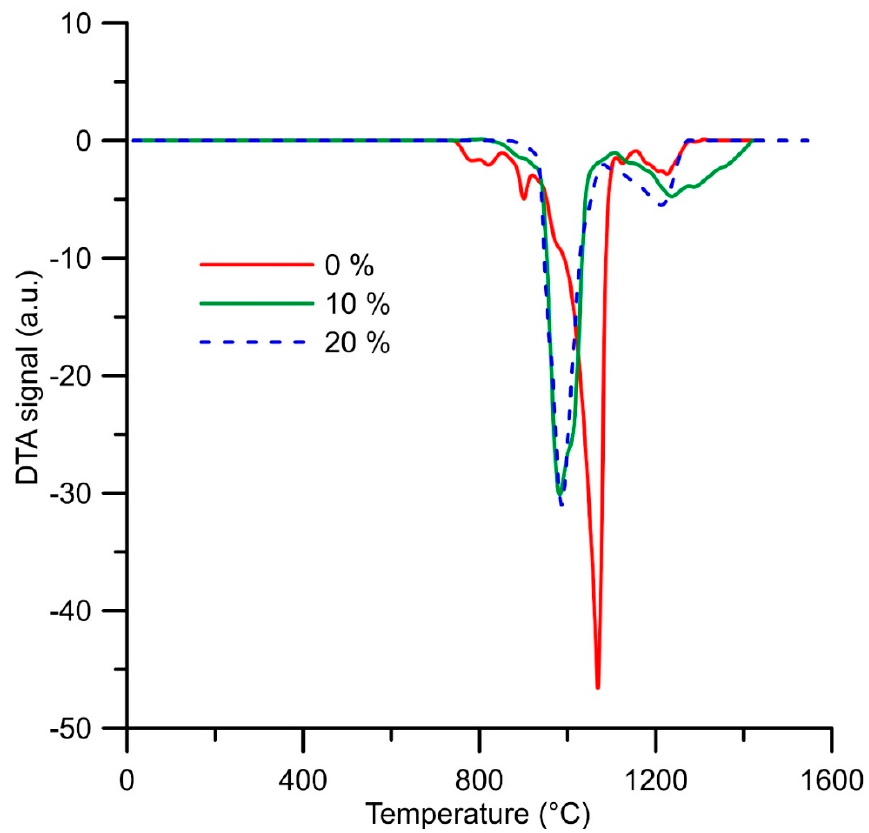
Figure 8. DTA heating curves of the alloys (in wt. %) prepared by reduction with a stoichiometric amount of aluminum (0%), with 10% excess of aluminum (10%) and with 20% excess of aluminum (20%).